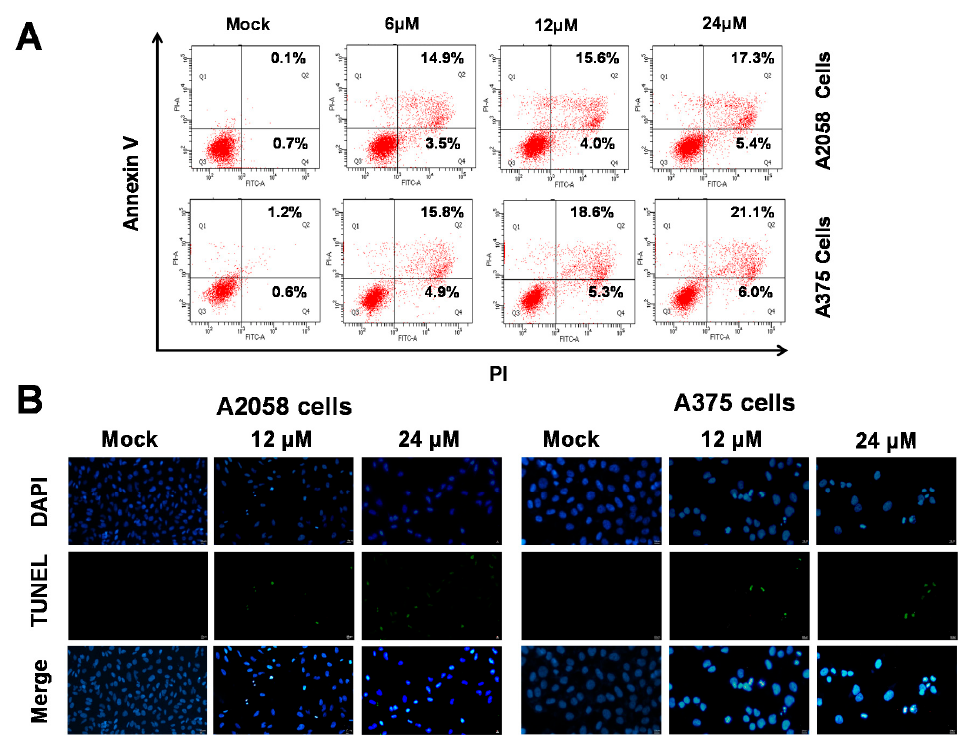
Figure 3. Detection of (+)-bornyl p -coumarate-induced apoptosis in A2058 and A375 melanoma cells by flow cytometry using FITC-annexin V and propidium iodide. ( A ) Percentages of late apoptotic cells in A2058 and A375 cells after ( + )-bornyl p -coumarate treatment. ( B ) Apoptotic DNA fragmentation and